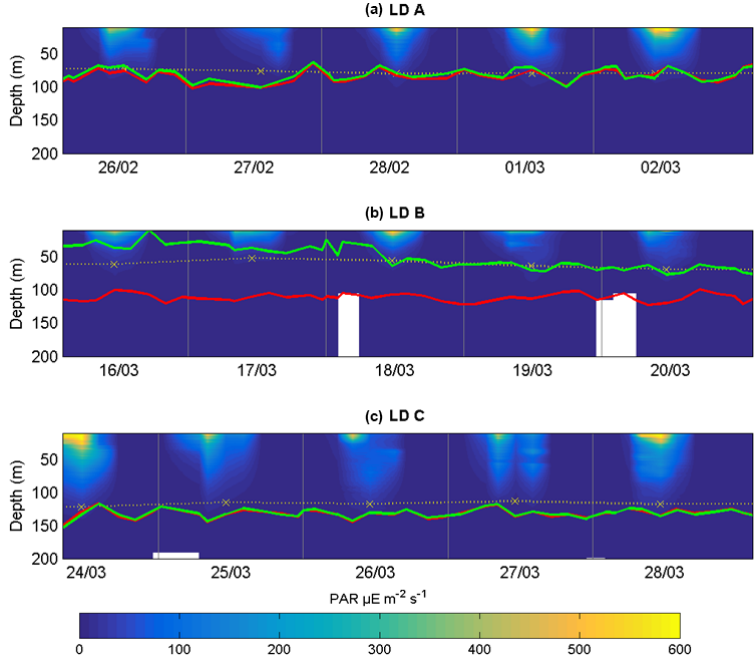
Figure 3. Temporal evolution of PAR, DCM (green line), ρ NO stations’ occupation period (LD A: a ; LD B: b ; LD C: c